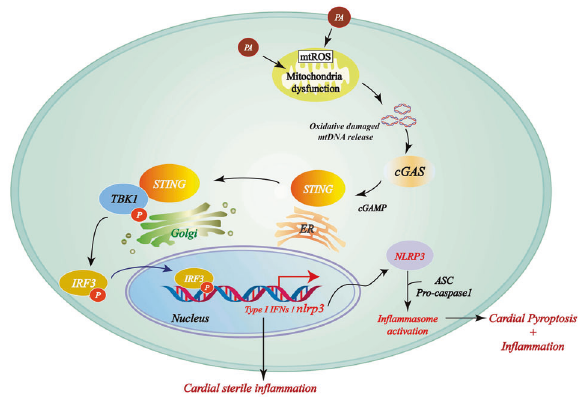
Fig. 6 Proposed mechanism of PA-induced myocardial pyroptosis mediated by cGAS-STING pathway activation in DCM. PA causes mitochondrial damage and the release of mtDNA into the cytosol, which is converted to cGAMP by cGAS. cGAMP activates STING, which facilitates TBK-1-mediated IRF3 phosphorylation. Phosphory- lated IRF3 enters the nucleus and induces type I